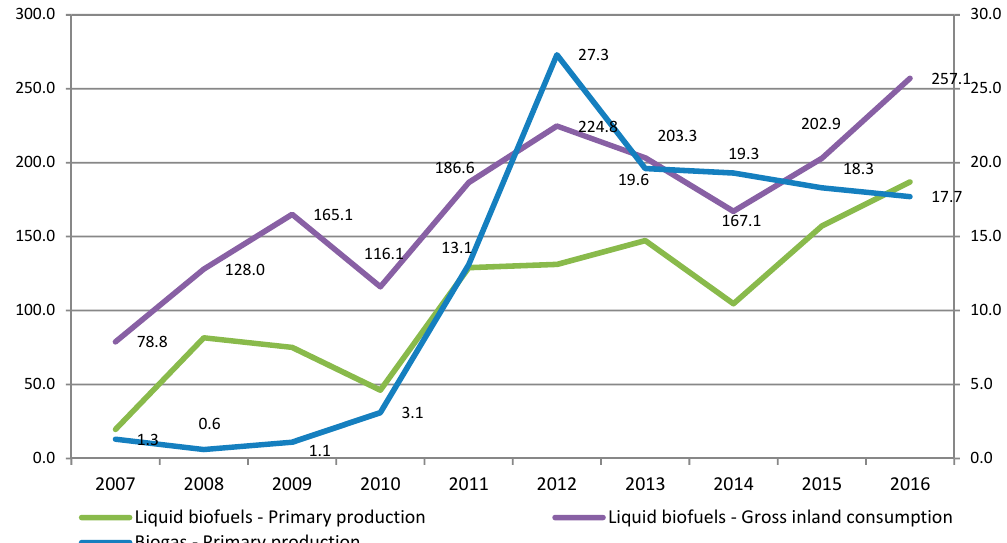
Figure 18. Main indicators evolution for biofuels and biogas, 2007–2016, Source: Own research based on Eurostat data [12].